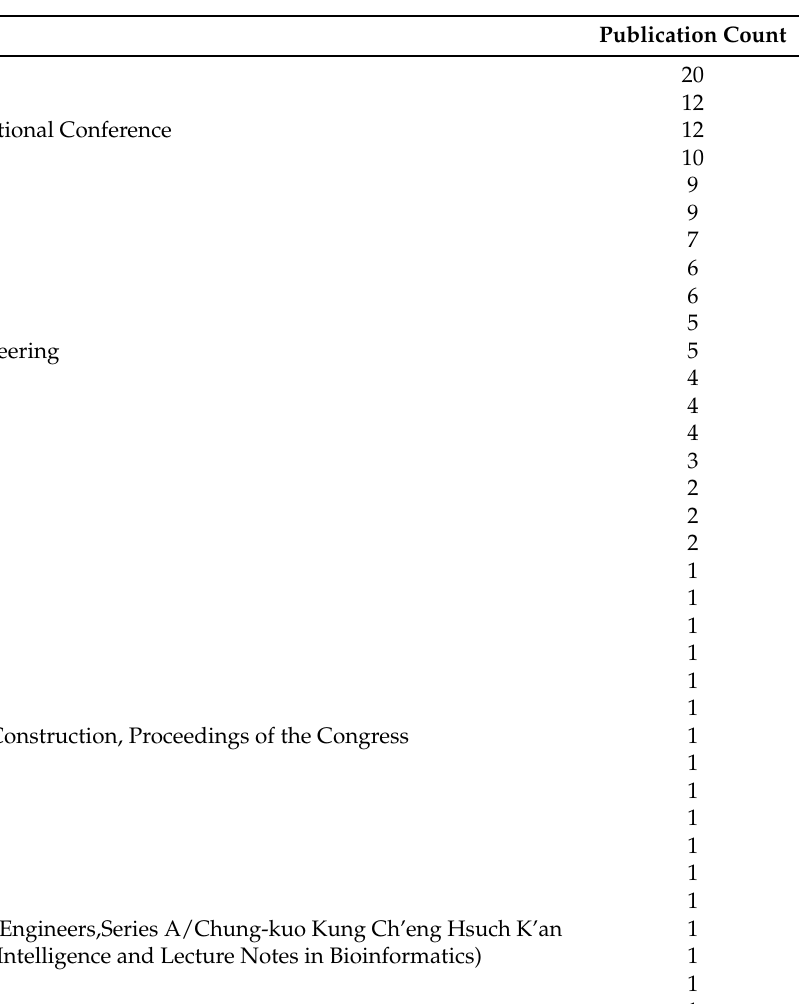
Table 2. Frequency ranking of publication